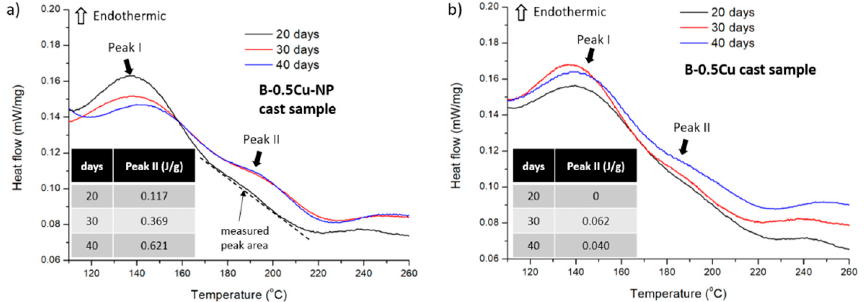
Figure 9. Heat flow during heating up the ( a ) B-0.5Cu-NP cast sample and ( b ) B-0.5Cu cast sample with different natural aging days. Peak I is an endothermic peak representing GPI zone dissolution. Peak II is an endothermic peak representing GPII zone dissolution. The inserted table is the calculated peak II area indicating the volume of GPII zones.